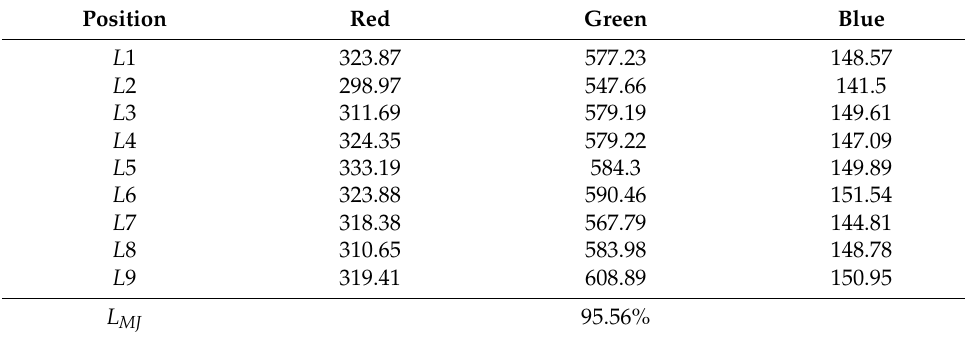
Table 2. The brightness of the randomly constructed display module (cd/m 2